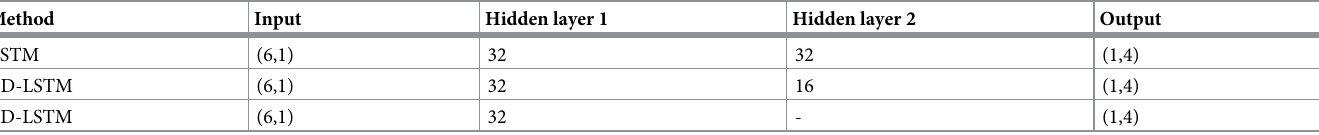
Table 5. Respective LSTM model topologies for the univariate case.